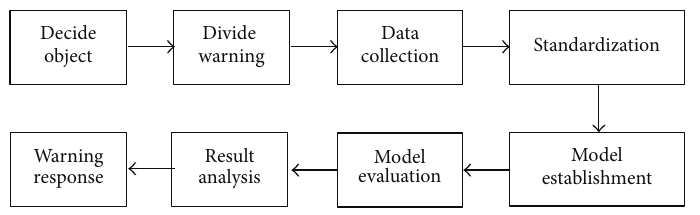
Figure 4: Steps to build the early risk warning model of risk.